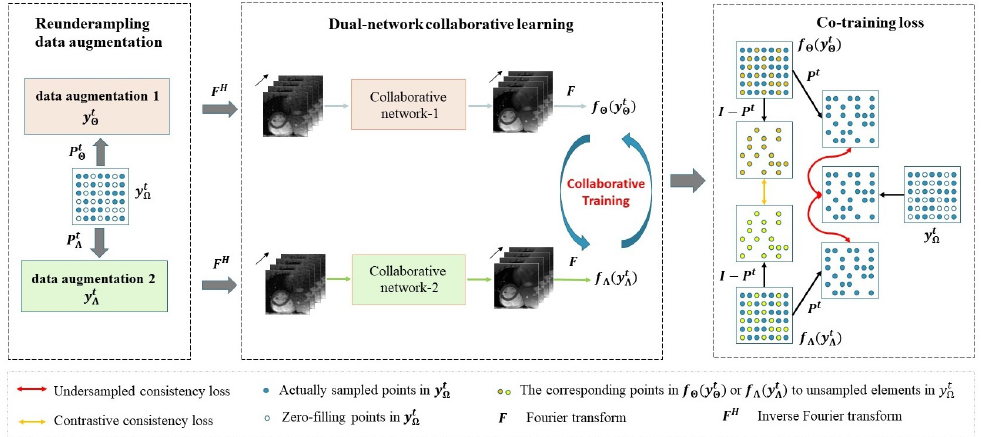
Figure 1. An overview of the proposed self-supervised collaborative training framework. A raw undersampled k-space data sequence y t Ω is undersampled from the fully sampled data using an un- dersampled mask P t retrospectively, and then two k-space data sequences y t Θ and y t Λ are augmented from y t Ω . In the considered scenario, y t Θ and y t Λ are reundersampled from y t Ω using reundersampled mask P t Θ and P t Λ , respectively. Next, the two networks received inputs from zero-filling image sequences of y t Θ and y t Λ . The predicted image sequences of networks are transformed to the k-space (cid:1) (cid:1) (cid:0) (cid:0) y t Θ y t Λ data f Θ and f Λ by two-dimensional Fourier transform. Afterward, a co-training loss is (cid:1) (cid:1) (cid:0) (cid:0) y t Θ y t Λ calculated using y t Ω , f Θ and f Λ . The backbone reconstruction network can flexibly adopt different iterative un-rolled network, such as CRNN, k-t NEXT and SLR-Net. Collaborative network-1 and collaborative network-2 have the same network structure but different weight parameters θ Θ and θ Λ